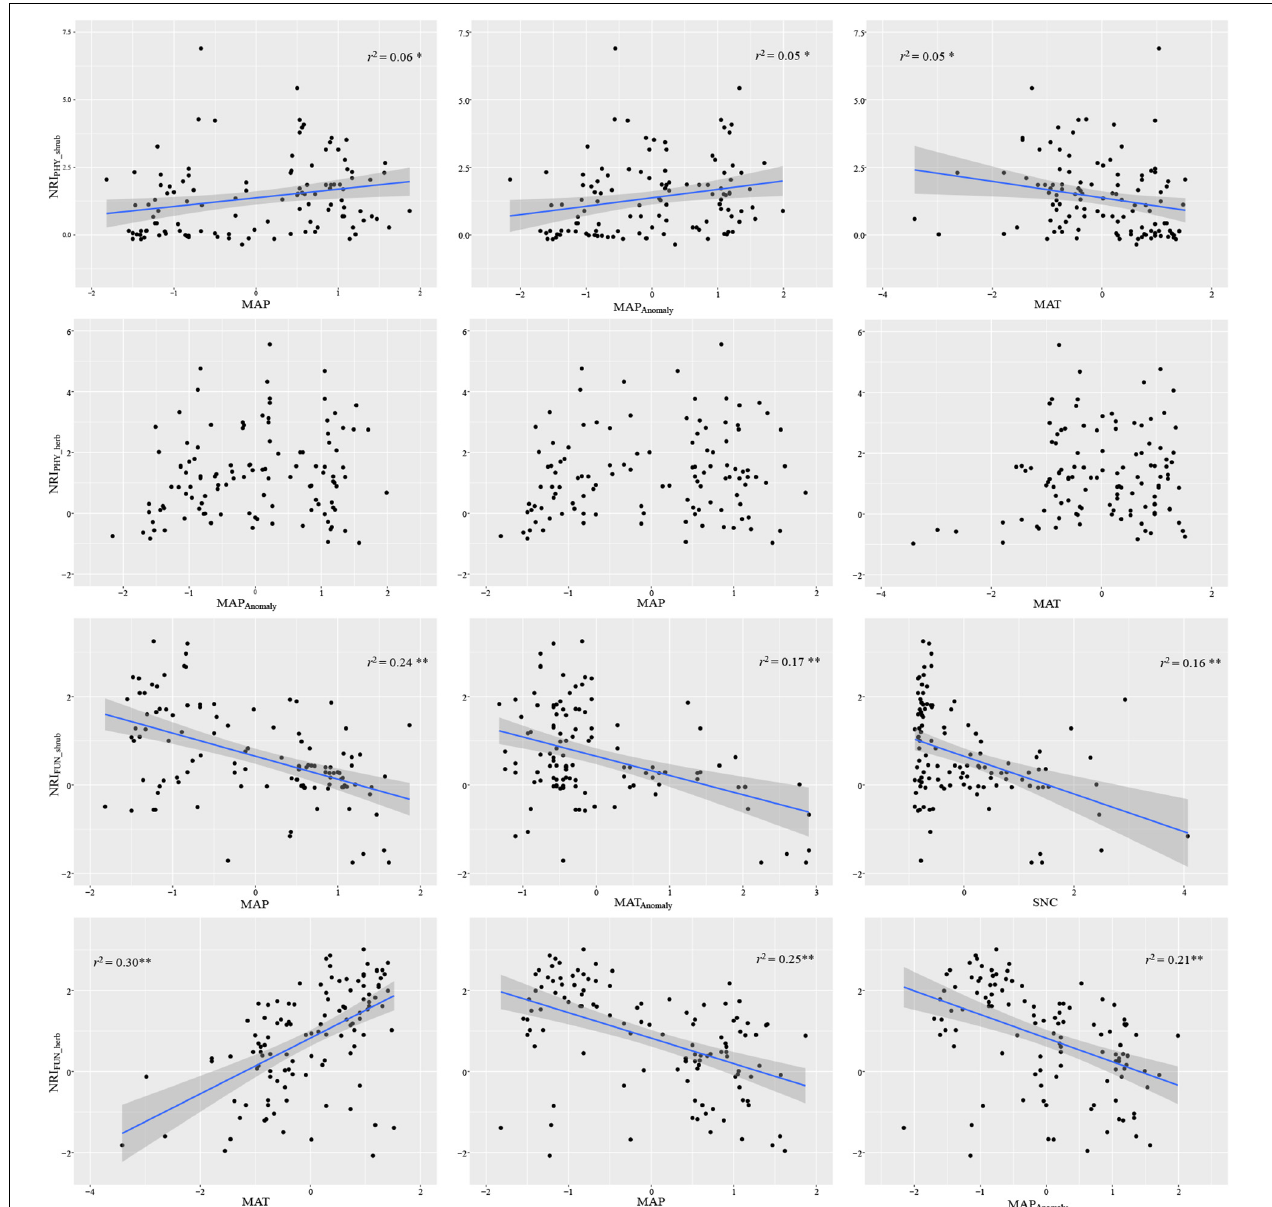
FIGURE 2 | Scatter plots of the three most associated variables against the different structure indices. NRI PHY_shrub , phylogenetic shructure of shrub; NRI PHY_herb , phylogenetic structure of herb; NRI FUN_shrub , functional structure of shrub; NRI FUN_herb , functional structure of herb. MAT, mean annual temperature; MAP, mean annual precipitation; SNC, soil nitrogen content; MAT Anomaly , MAT anomaly; MAP Anomaly , MAP